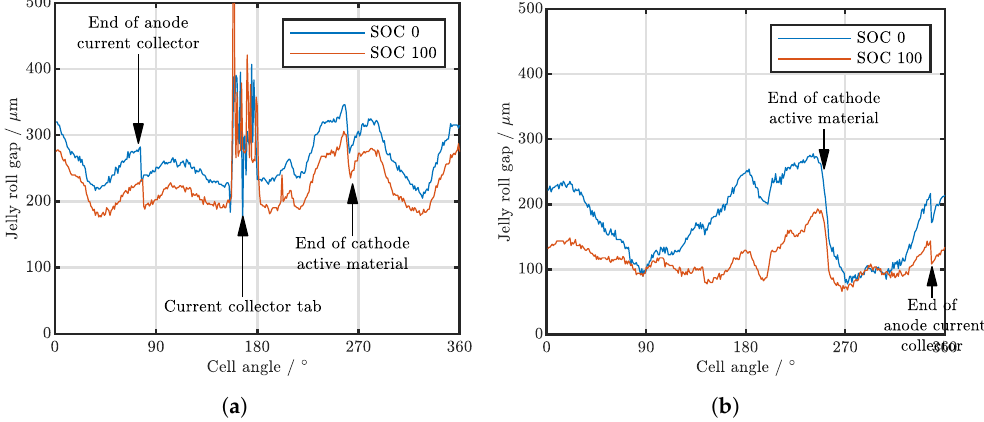
Figure 7. Jelly-roll gaps for various new 21700 lithium-ion batteries at 0% and 100% SOC. ( a ) Jelly-roll gap for a Molicell INR21700 cell. ( b ) Jelly-roll gap for a Samsung INR21700-40T cell. Table 2. Overview of jelly-roll gap sizes at various SOCs for new